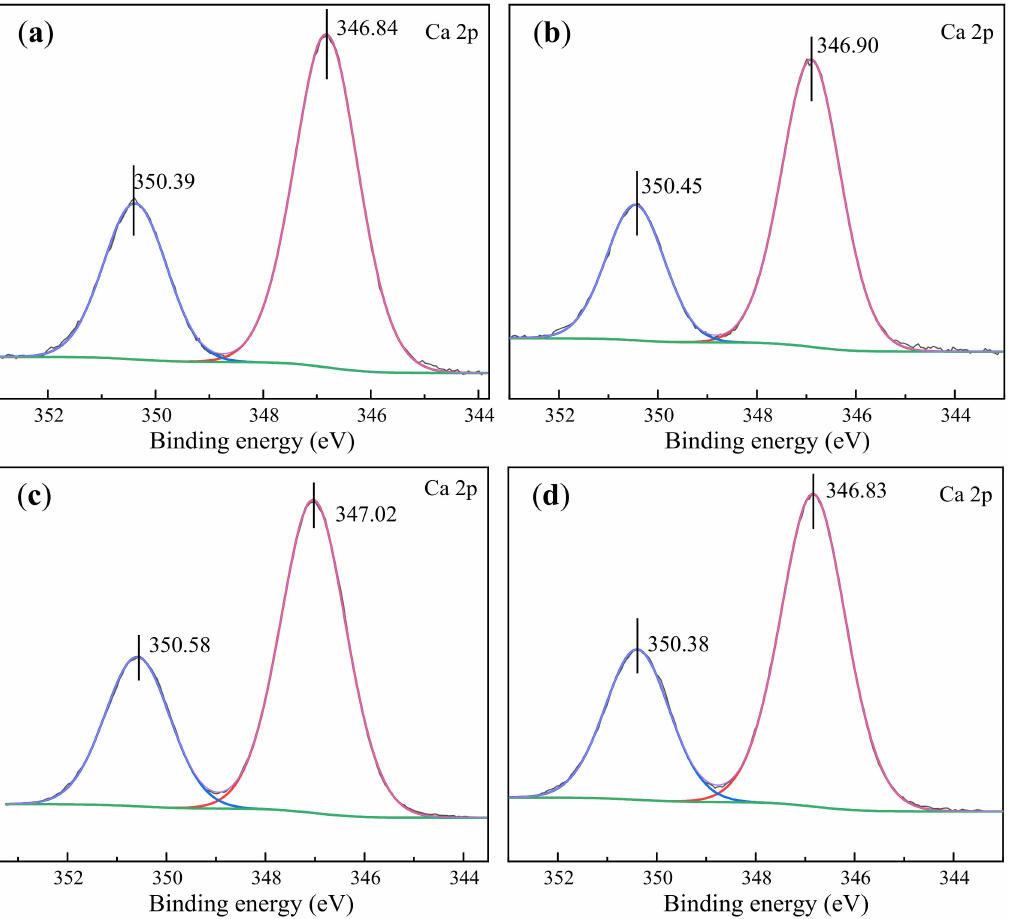
Figure 10. XPS spectra of Ca 2p signals of scheelite and calcite in the presence and absence of SNF: ( a ) scheelite; ( b ) scheelite treated with SNF; ( c ) calcite; ( d ) calcite with